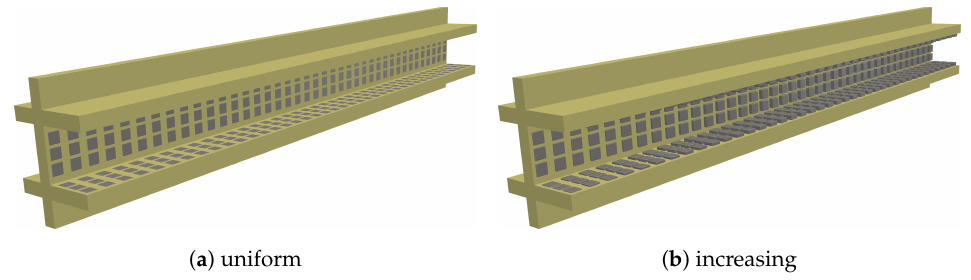
Figure 5. Channel model with modified PM layer height.